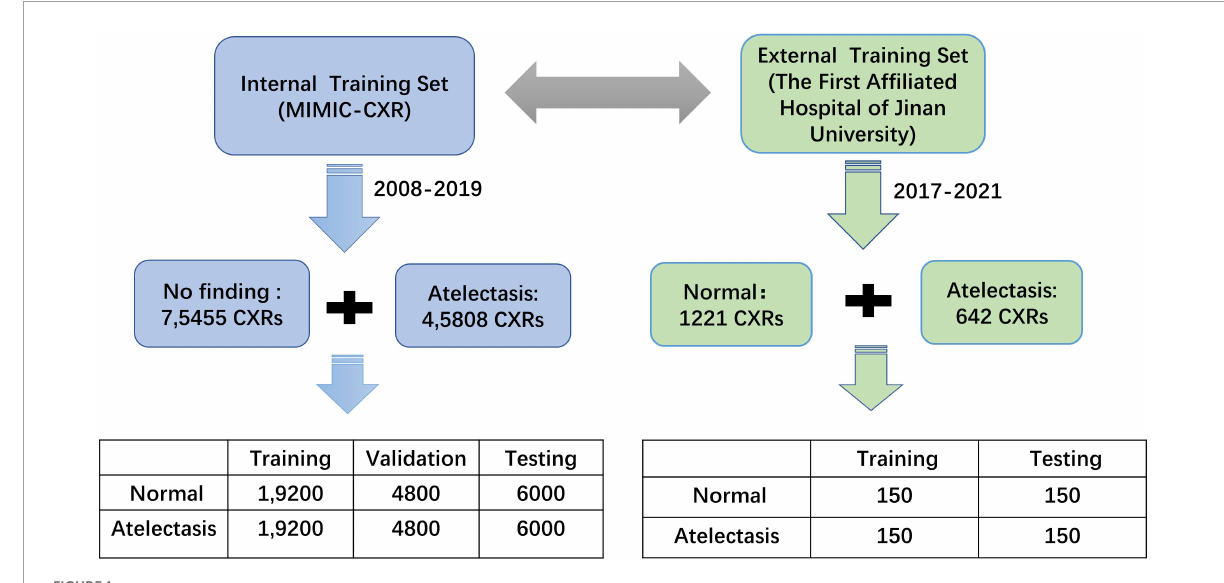
FIGURE1 Data flow design of the internal and external datasets.